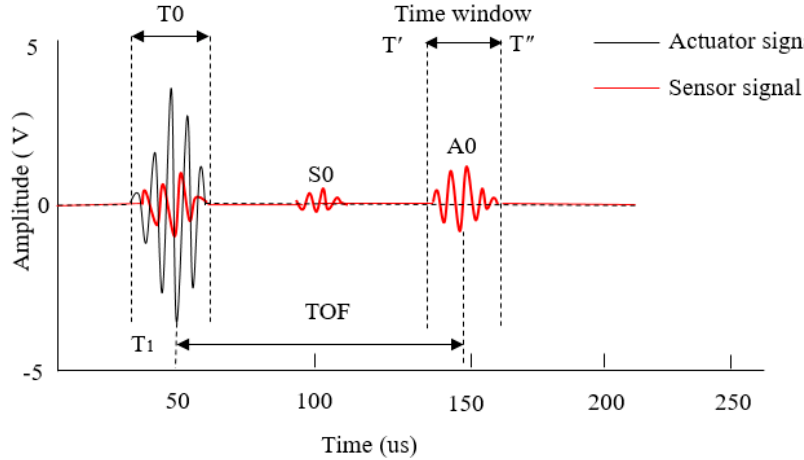
Figure 7. Intercepting the A0 mode wave packet of Lamb wave using an actuator signal (in black) and a sensor signal (in red).